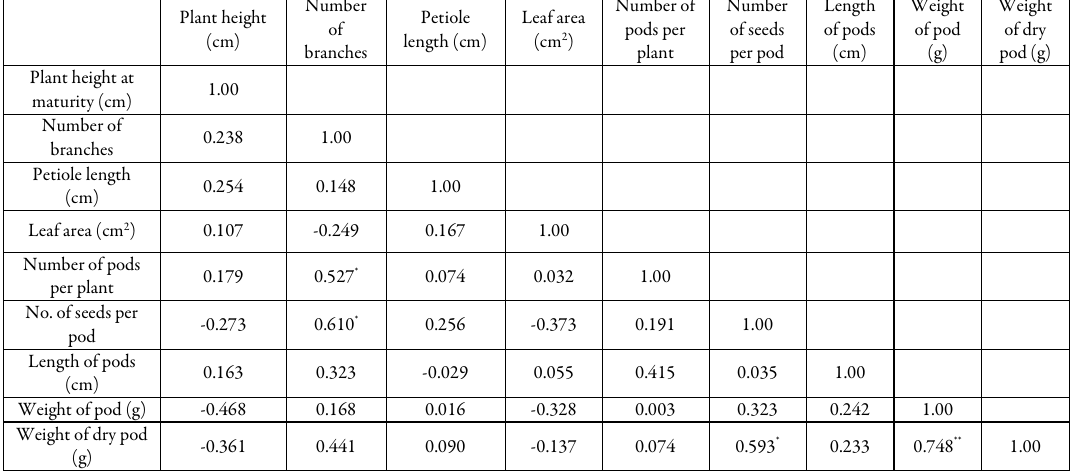
Plant height (cm)